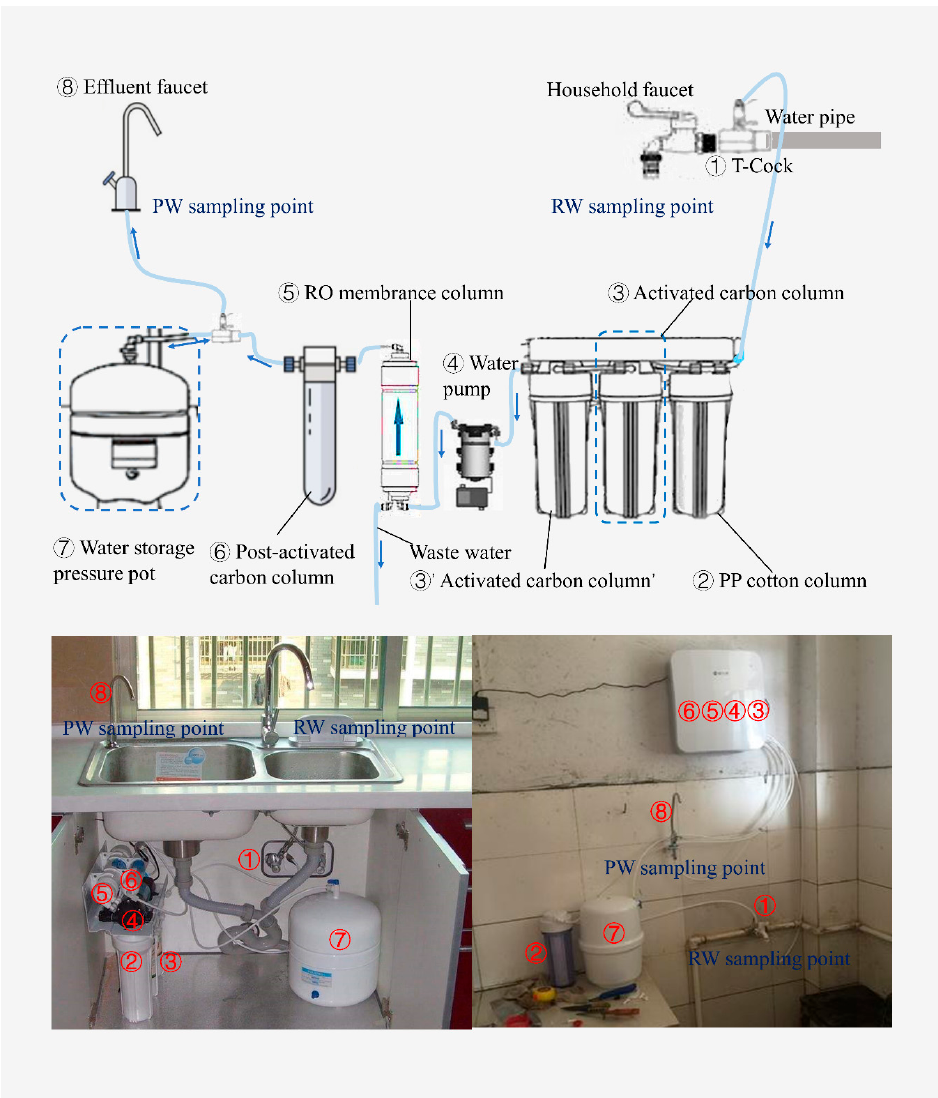
Figure 2. Schematic diagram and photographs showing the typical installed water treatment system (the dotted line indicates that this component is only available on some devices, and the numbers on the two photographs show the corresponding components in two systems).